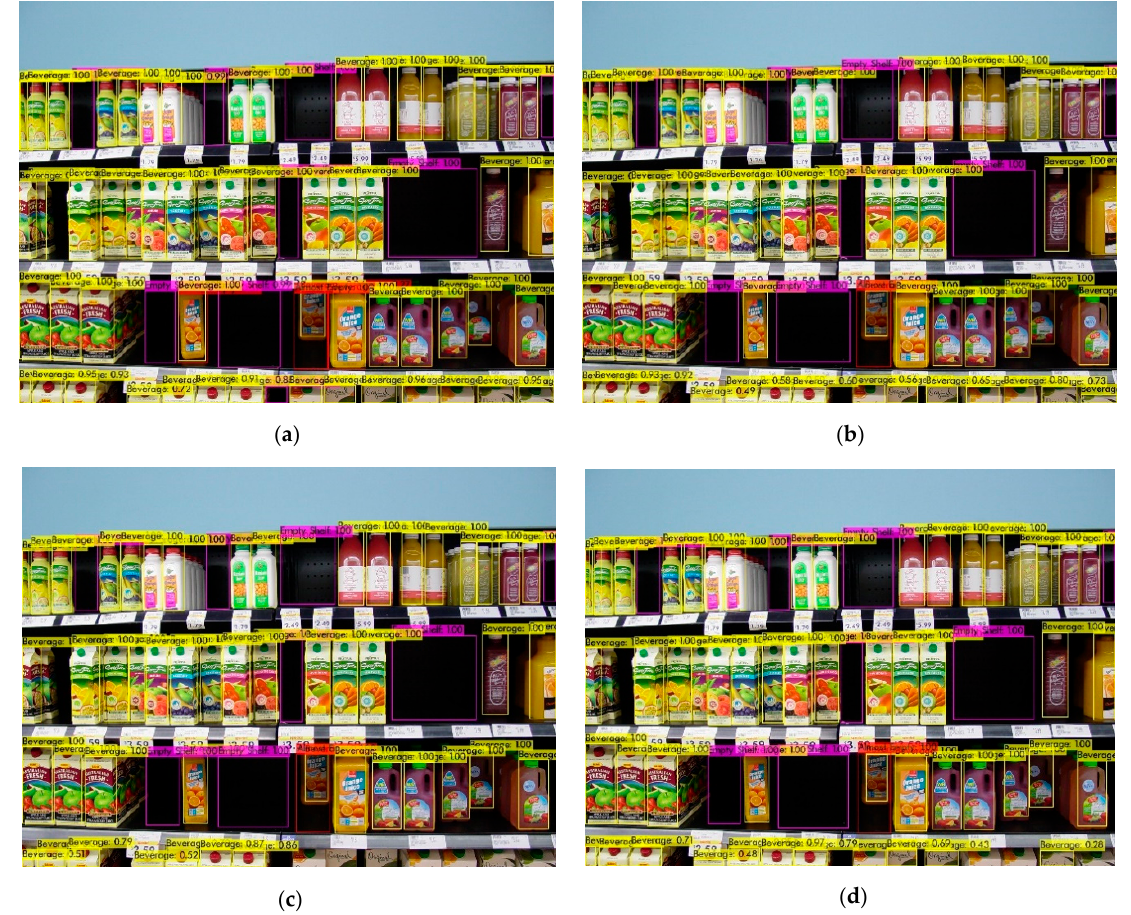
Figure 14. Sample object detection results of the beverage section. It shows detection results using the model that was trained with ( a ) 20% of labeled images; ( b ) 40% of labeled images; ( c ) 60% of labeled images; and ( d ) 80% of labeled images.